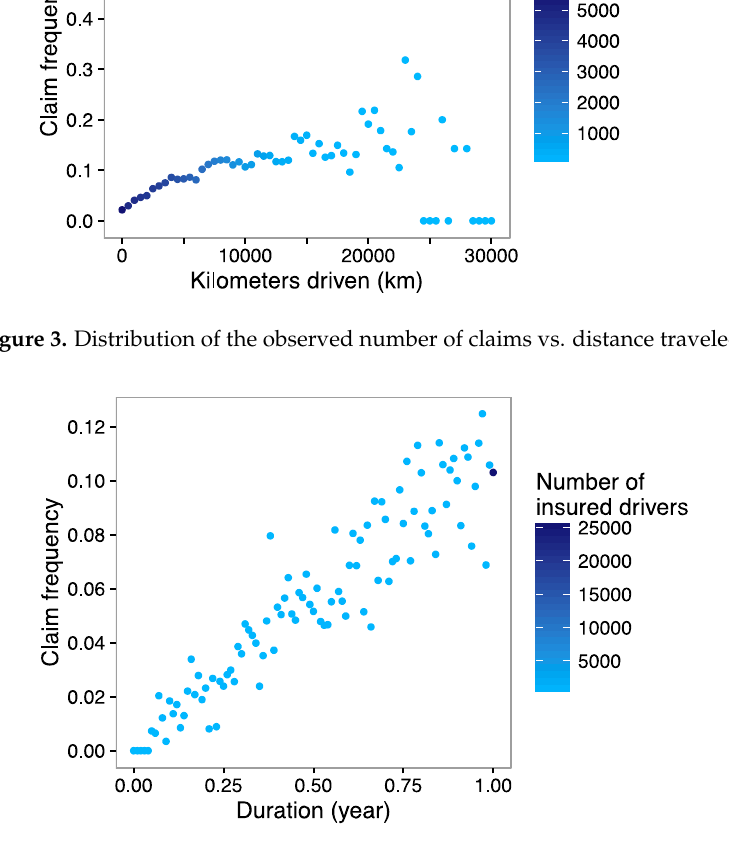
Figure 4. Distribution of the observed number of claims vs. exposure duration.